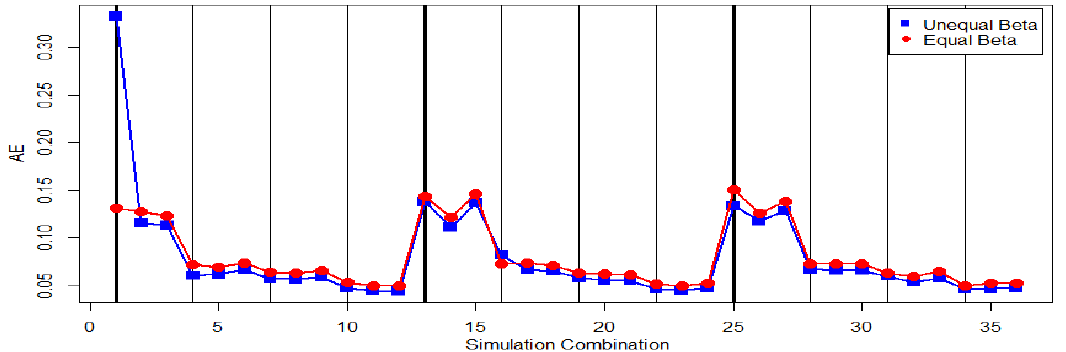
Figure 7. The values of EAE ( ˆ δ AE ) for the cases of β 1 = β 2 and β 1 (cid:54) = β 2 .